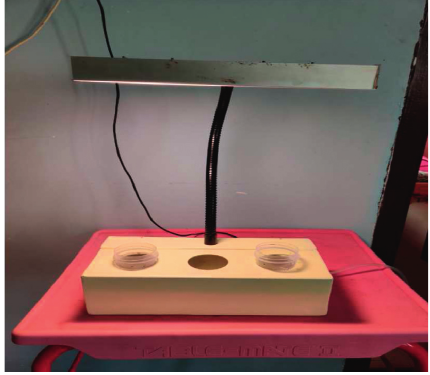
Figure 29: LED system with white (3000 CCT) LED ON.